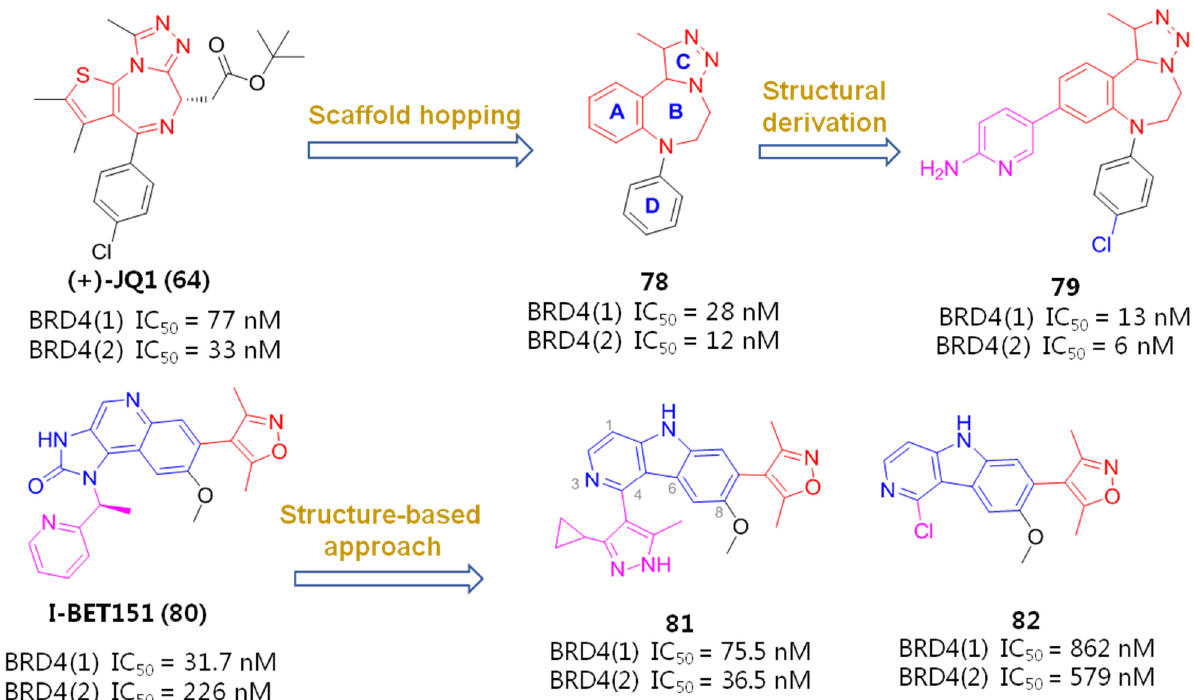
Figure 14. Chemical modifications from JQ1 and I-BET151 led to several more potent BETIs.